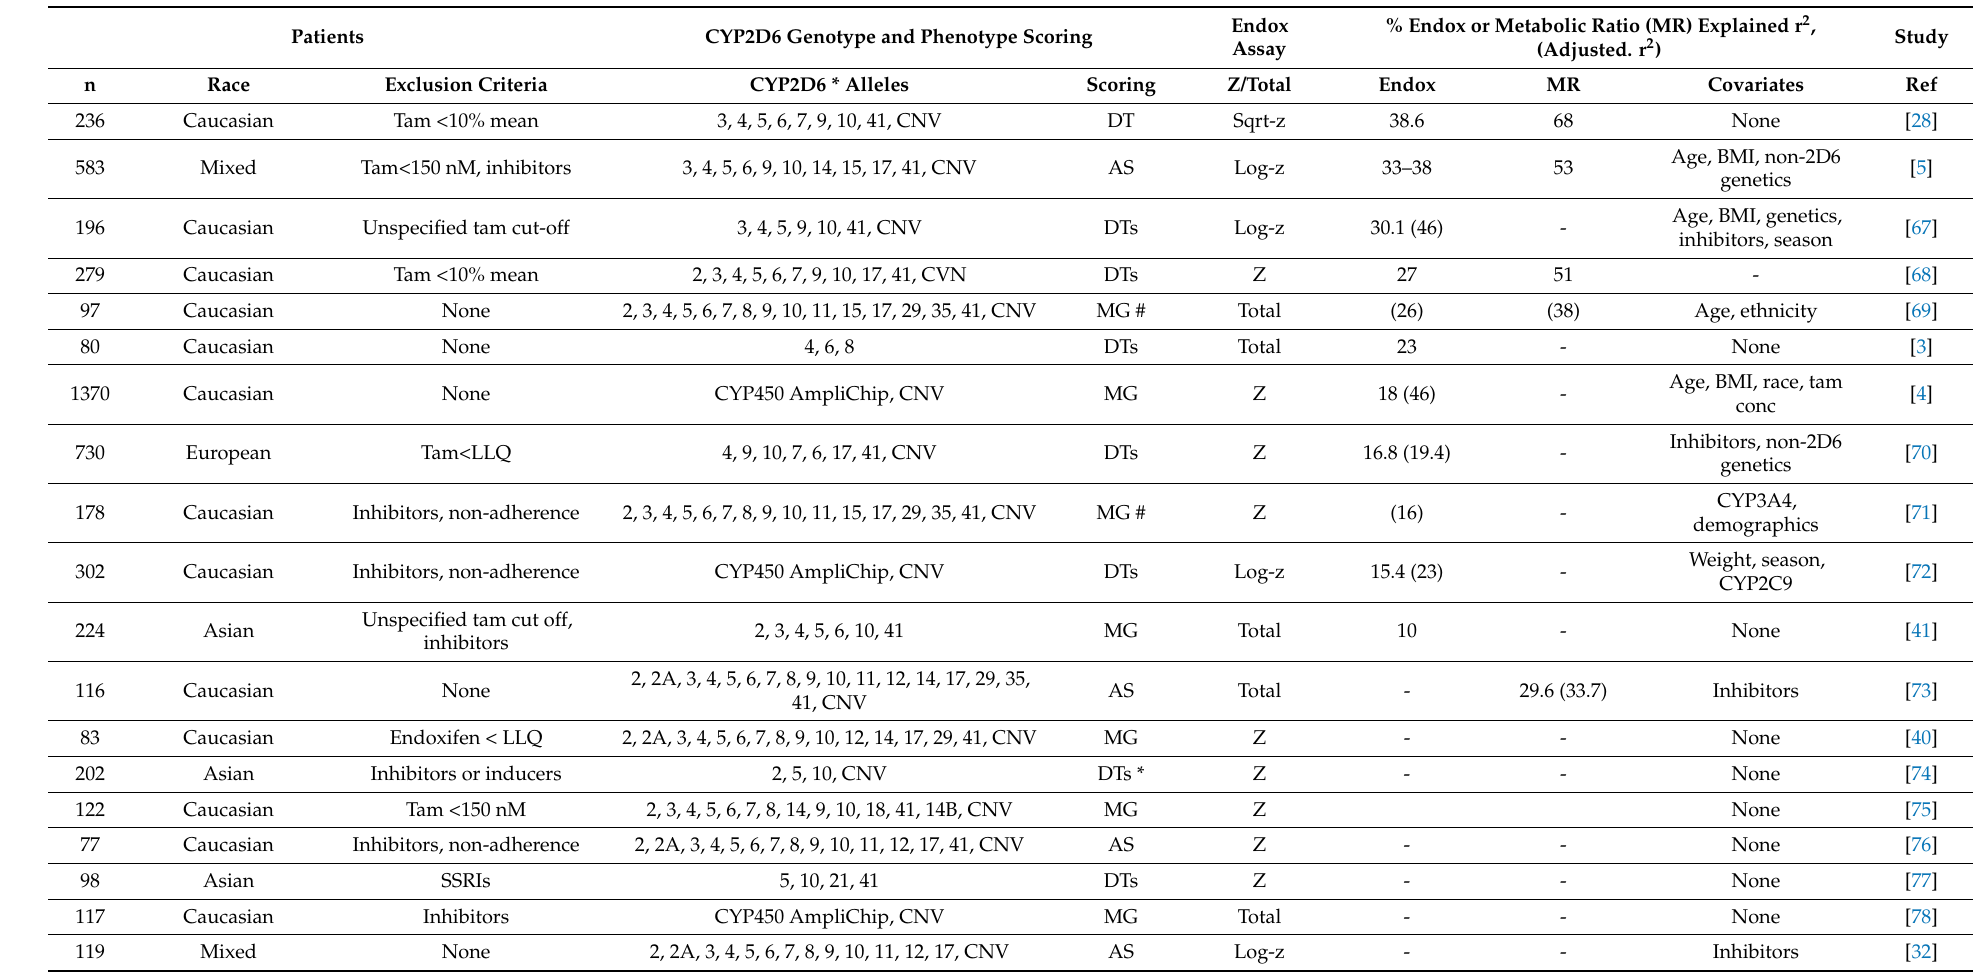
Table 3. Overview of studies reporting CYP2D6 genotypes in correlation with endoxifen